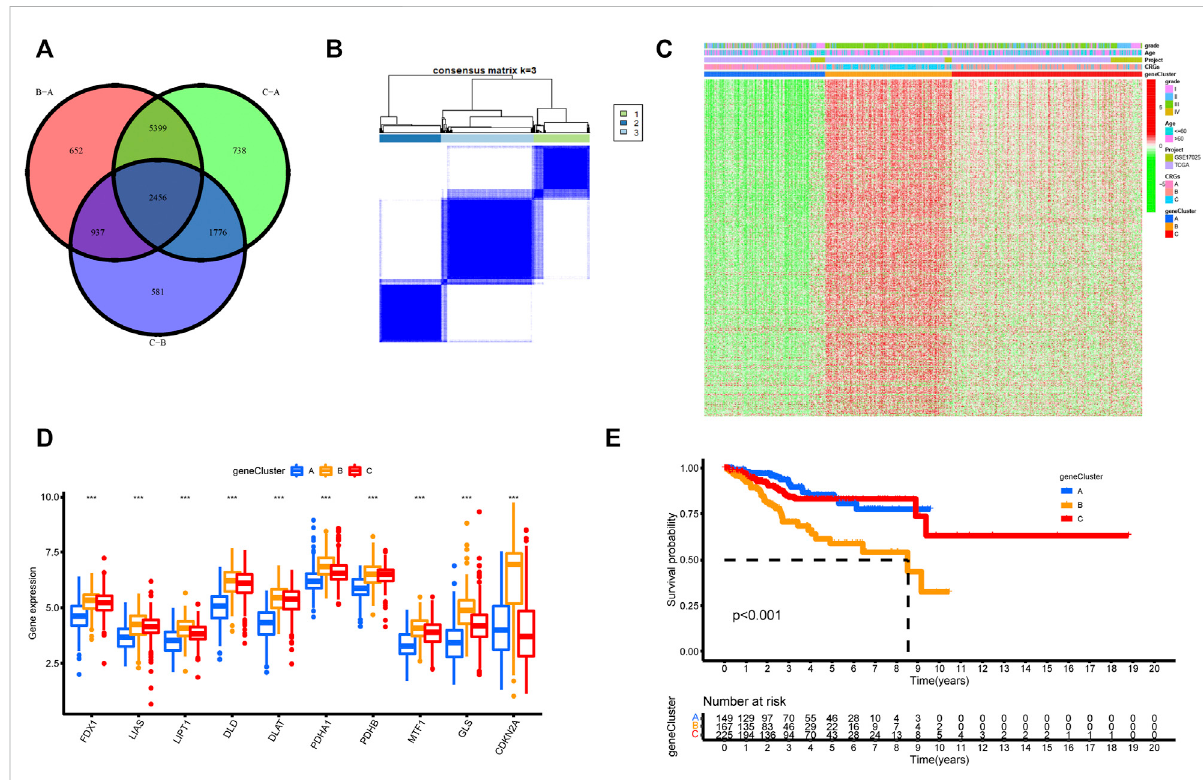
FIGURE 5 Unsupervised clustering of cuproptosis-related genes according to TCGA-UCEC and GSE17025 cohort. (A) 2,456 cuproptosis-related genes from TCGAare presented in theVenndiagram. (B) Consensusclustering matrix ofcuproptosis-related genes for k = 3using unsupervised clustering analysis. (C) The unsupervised clustering analysis of the CRGs gene clusters A, B, and C. CRGs clusters, CRGs gene clusters, grade, and age were noted.Redrepresentedhighexpression,andgreenrepresentedlowexpression. (D) Thehistogramillustratedtheexpressionof10CRGsinthree CRGs gene clusters. The upper and lower ends of each box mean the quartile range of the value, the middle line represents the median value. The statistical p -value is shown by an asterisk (* p < 0.05, ** p < 0.01, *** p < 0.001). (E) Kaplan – Meier survival analysis for the three CRGs gene clusters ( p -value <